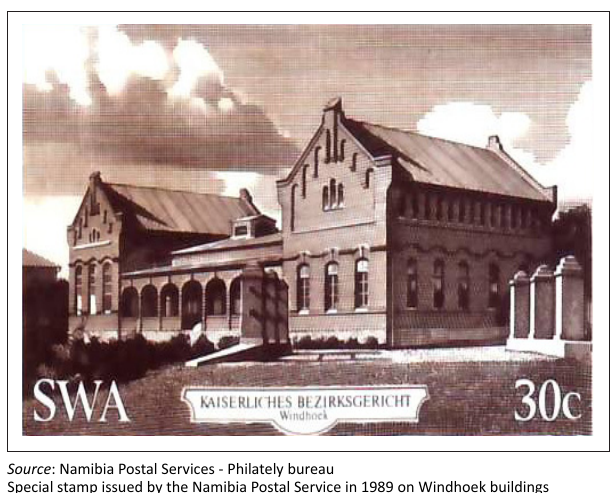
FIGURE 6: Imperial High Court Windhoek, now the Central Veterinary